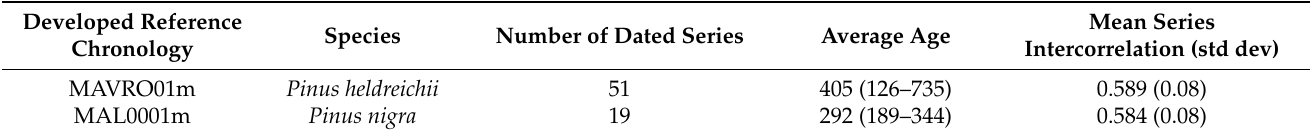
Table 2. Descriptive statistics of the reference chronologies developed for the two pine species. The average age per species is reported together with the minimum and maximum values of the sampled trees. Standard deviation (std dev) is provided for the mean series intercorrelation.